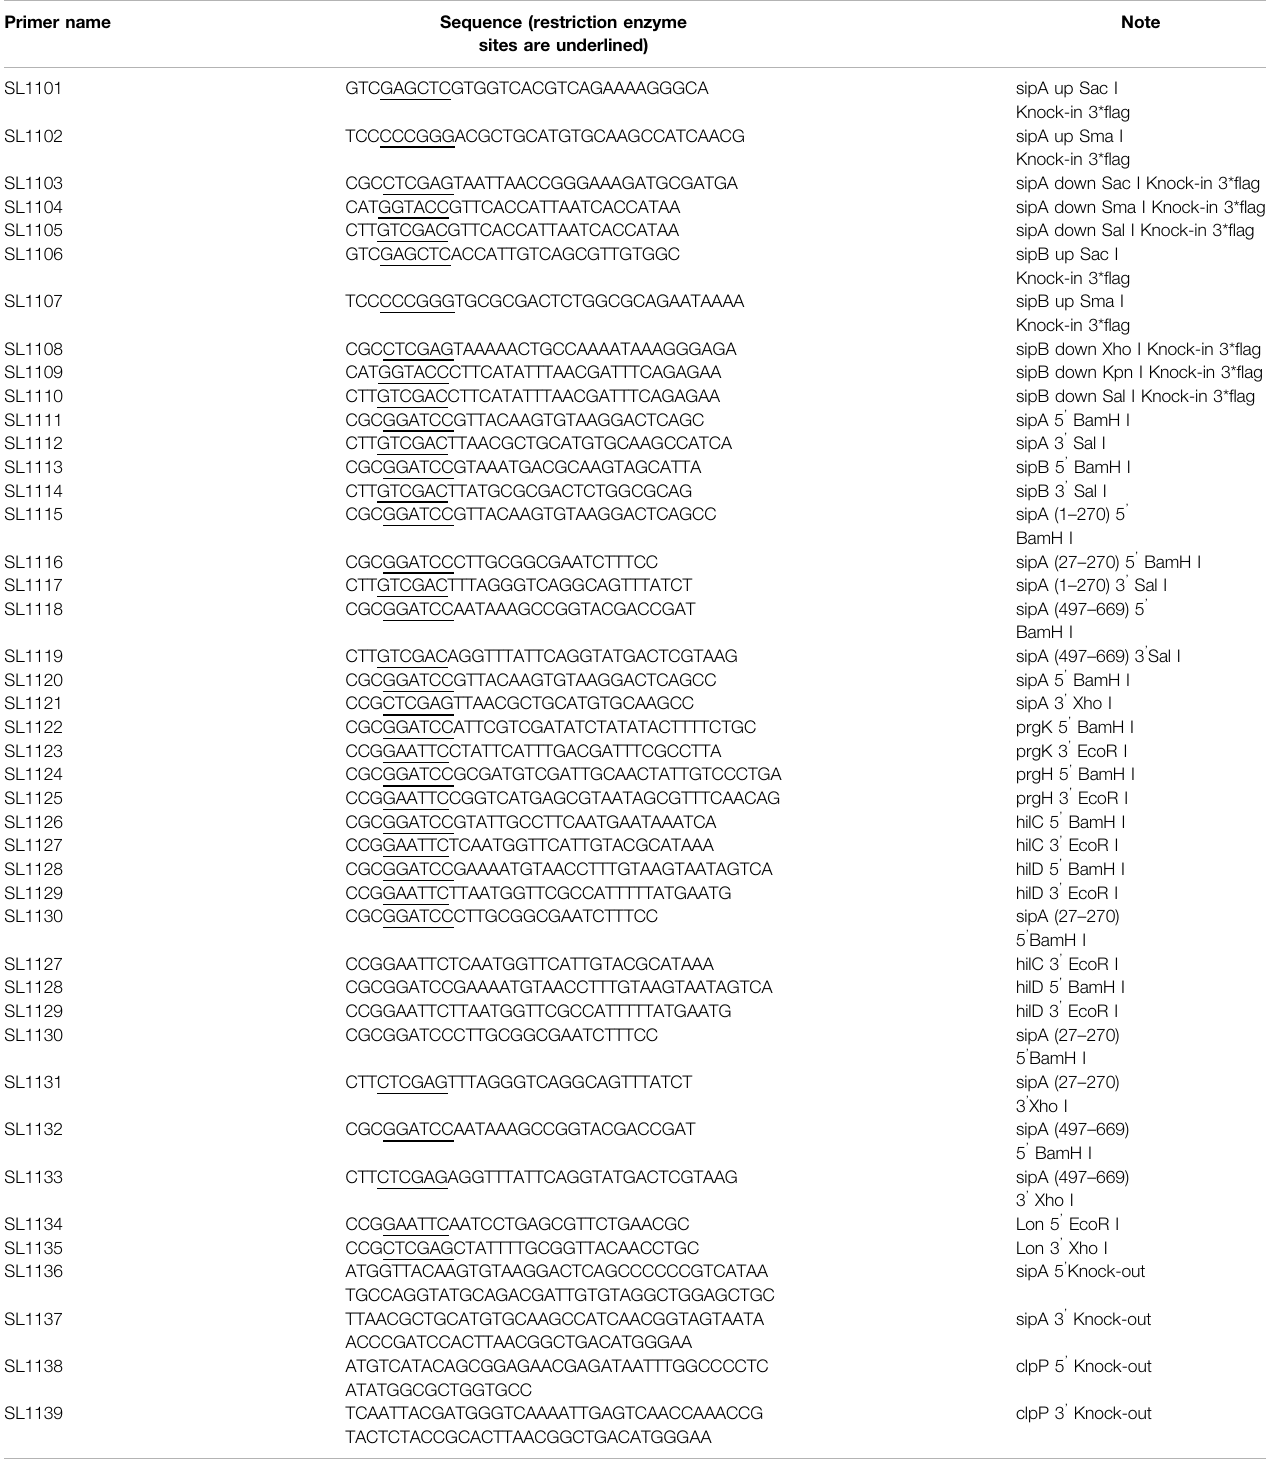
TABLE 2 | Primers used in this